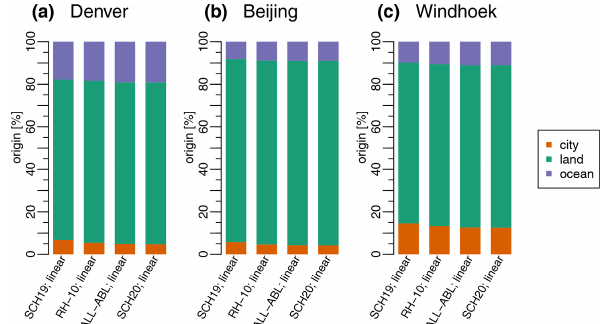
Figure 7. Origins of heat subdivided into local (orange), other land (green), and ocean (blue) source regions for (a) Denver, (b) Beijing, and (c) Windhoek, averaged over the period 1980–2016, as well as for different H detection criteria (RH-10; ALL-ABL; SCH19; SCH20) along the columns. City origins indicate the percentage of heat originating from a 3 ◦ × 3 ◦ box around the center of each city (i.e., local origins). Columns in each panel are sorted in descending order of the local contributions (orange